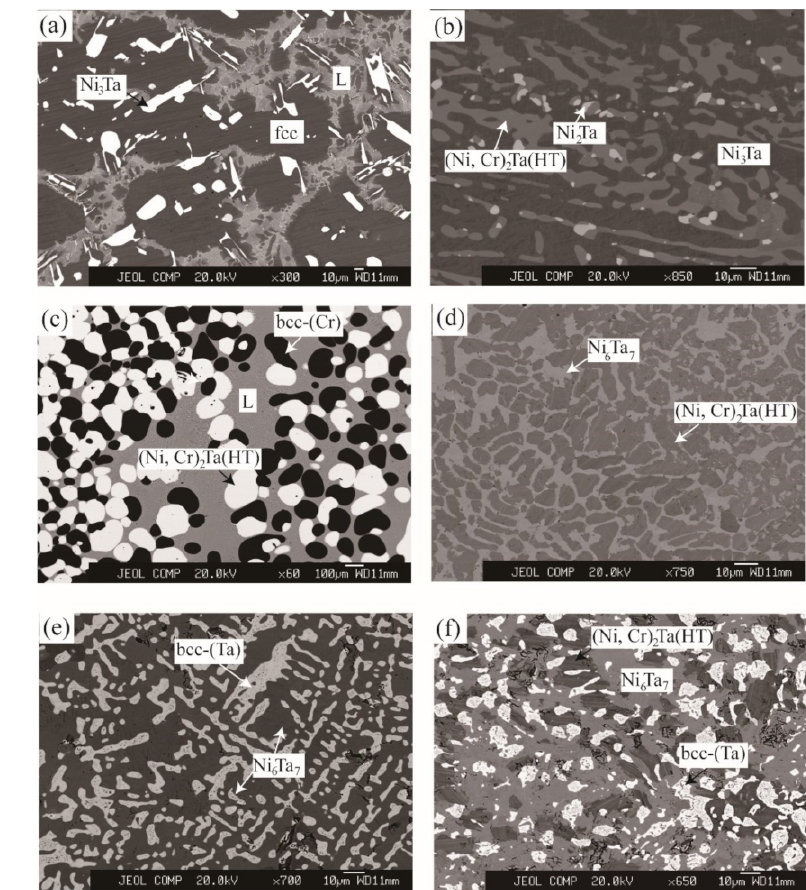
Figure4. ThemicrostructureoftypicalalloysintheNi-Cr-Tasystemannealedat1300 ◦ C.( a )Ni 59 Cr 33 Ta 8 ; ( c ) Ni 35 Cr 53 Ta 12 alloys annealed at 1300 ◦ C for 3 h. ( b ) Ni 65 Cr 5 Ta 30 ; ( d ) Ni 16 Cr 38 Ta 46 ; ( e ) Ni 12 Cr 33 Ta 55 ; ( f ) Ni 5 Cr 40 Ta 55 alloys annealed at 1300 ◦ C for 15 days.